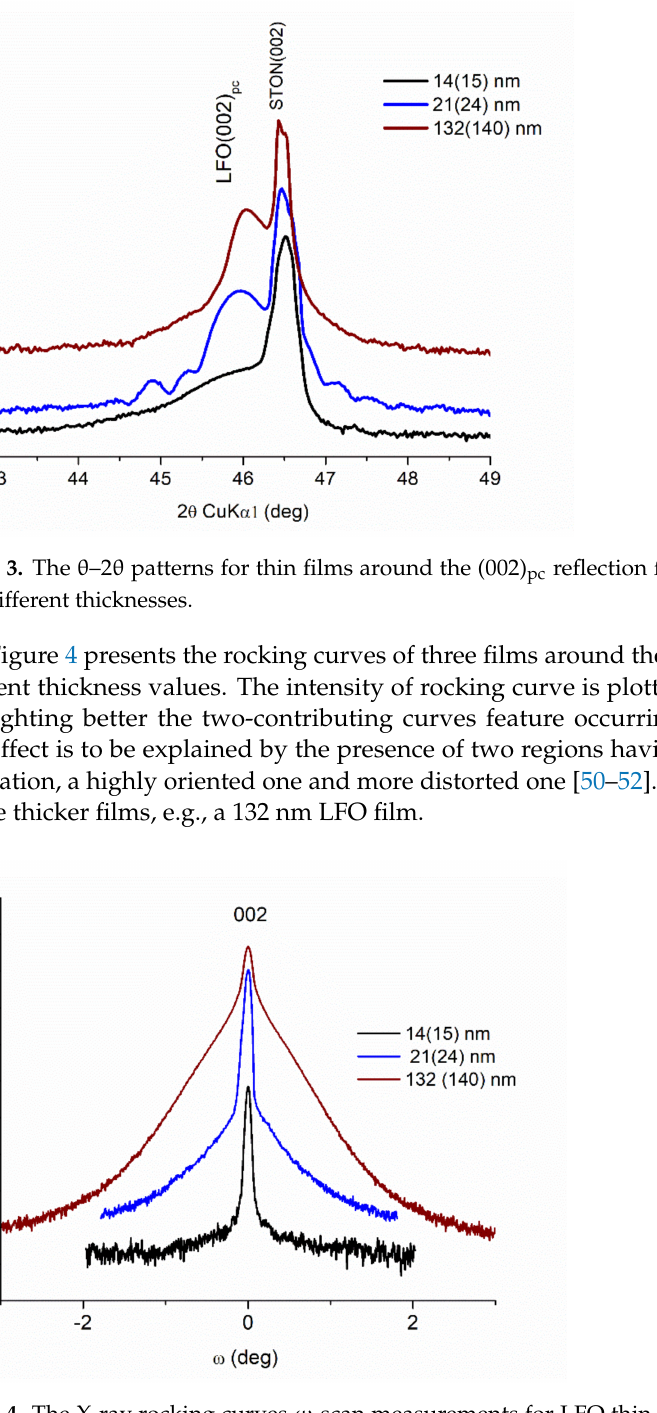
Figure 4. The X-ray rocking curves ω -scan measurements for LFO thin films with different thick- ness